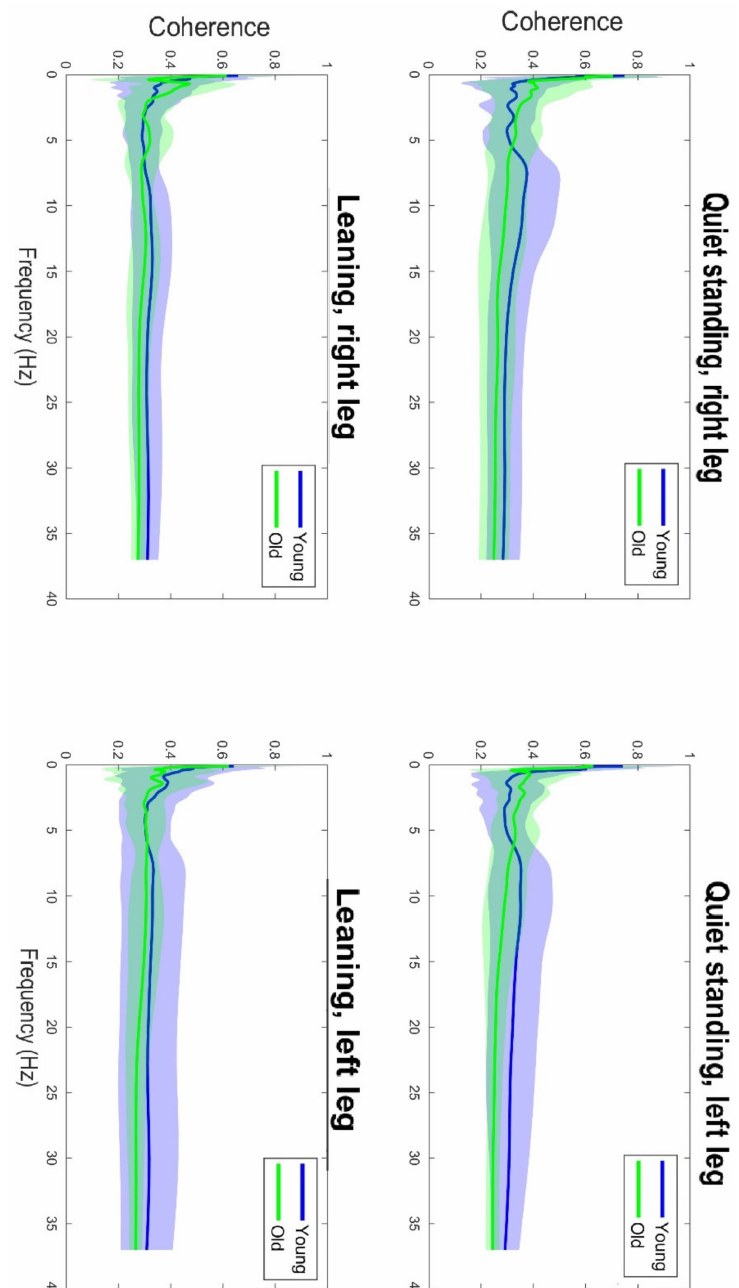
Figure 3. Graphical illustration of the asymmetry (left/right leg) of the delta and beta band coherence oscillations in the tasks (qs/leaning) in both